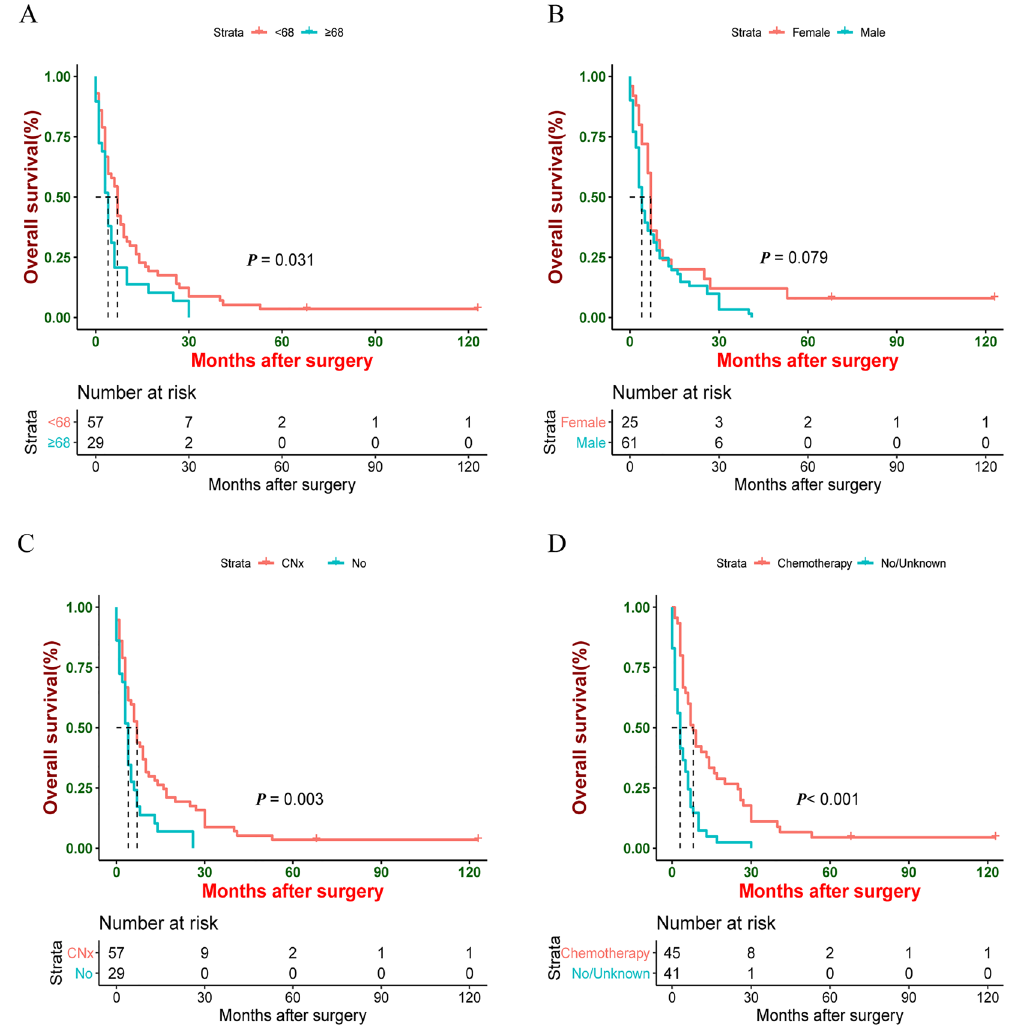
Figure 1. Kaplan–Meier estimate of Overall Survival (OS) by ( A ) Age, ( B ) Sex, ( C ) CNx, ( D )